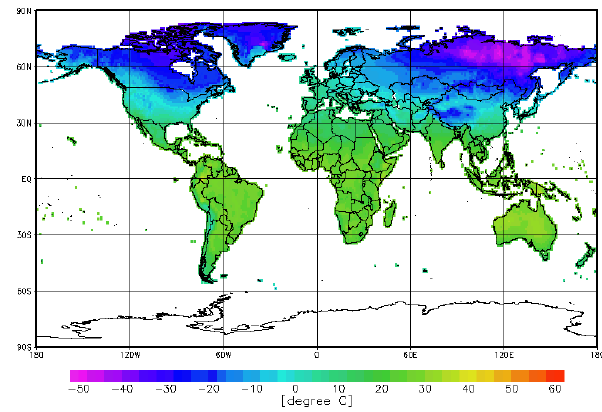
Figure 2. Monthly mean temperature in degrees Celsius as in Fig. 1, but reduced to the GPCC grid with 1.0 ◦ spatial